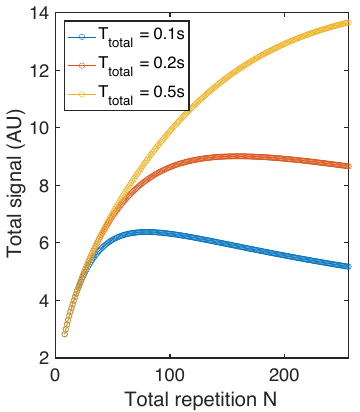
Figure 7. Total signal with RARE sequence. The simulation is conducted based on parameters close to diamonds ( T 1 = 50 s, T 2 = 1 ms, TE = 0.5 ms). The total signal curve S ( N ) maximize at different N when t total is set to different